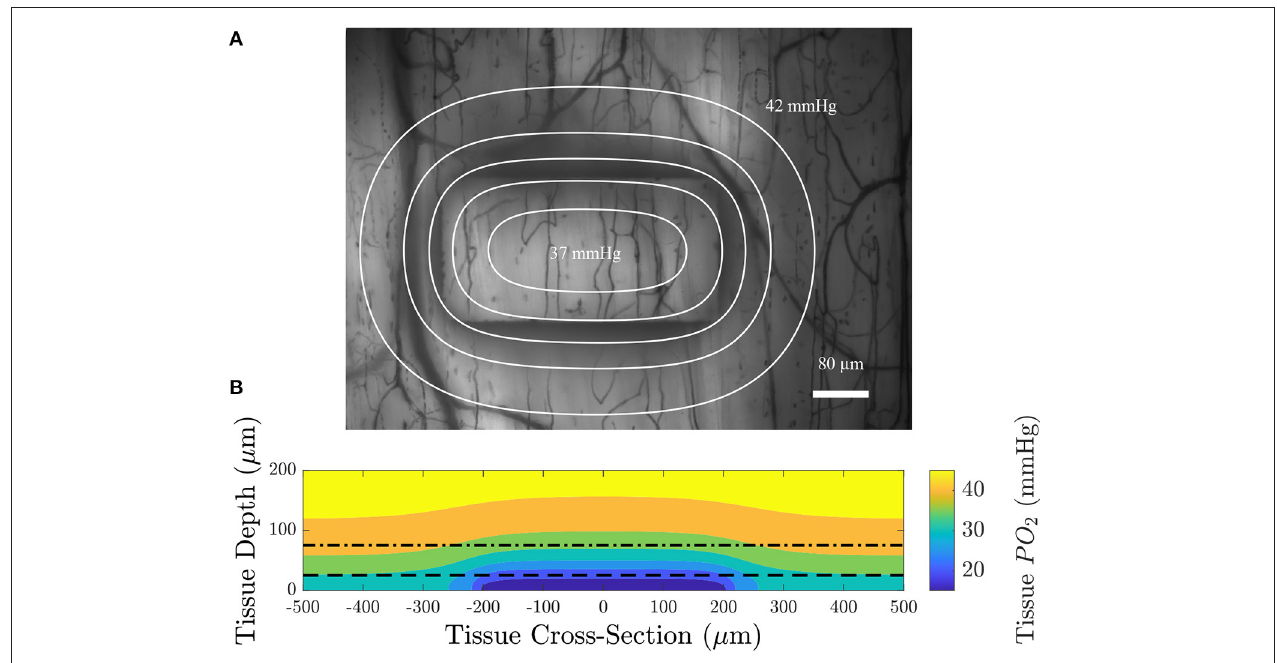
FIGURE 5 | (A) An intravital video microscopy functional image of the minimum pixel intensity over time with contour lines displaying constant PO 2 at a depth of 75 µ m from the top surface of the glass slide (dotted dashed line in B ); each contour is spaced 1 mmHg apart. (B) A colormap of the oxygen distribution as a function of depth in the tissue for a section through the long axis of the window; the dashed line indicates the location of the top of the PDMS layer and the dotted dashed line indicates the position of the imaging plane. The model predicts that the area affected by low oxygen challenges imposed by the gas exchange platform extend over an approximate area of 614 by 434 µ